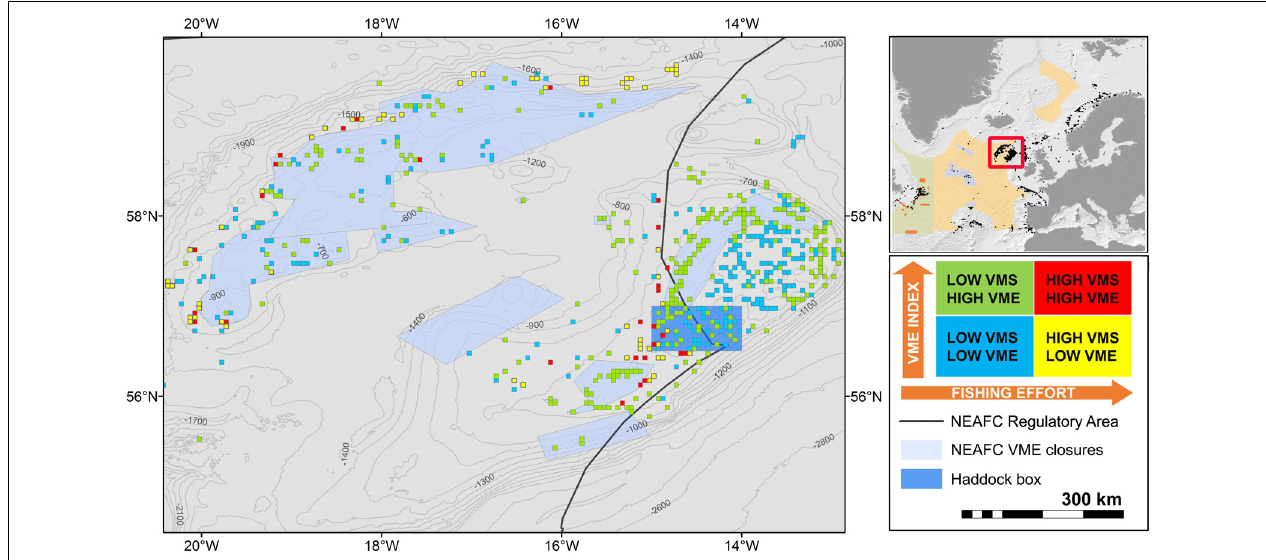
FIGURE 8 | Application of the portfolio categories concept to the Hatton-Rockall area. Blue cells are low VME – low VMS, yellow cells are low VME – high VMS, green cells are high VME – low VMS, and red cells are high VME – high